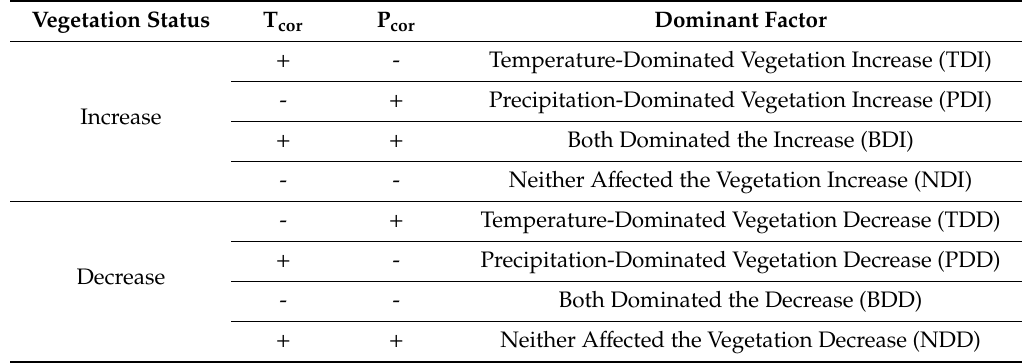
Table 4. Scenarios for the estimation of individual impacts of climate